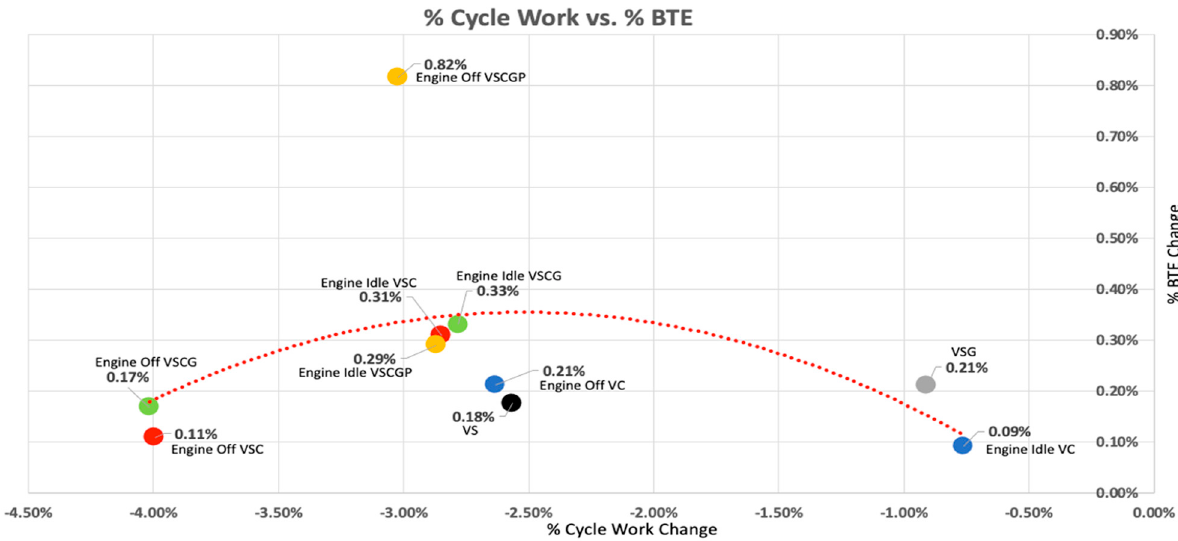
Figure 15. % Change in brake thermal efficiency as a function of % change in cycle work for different combination of optimal problems.